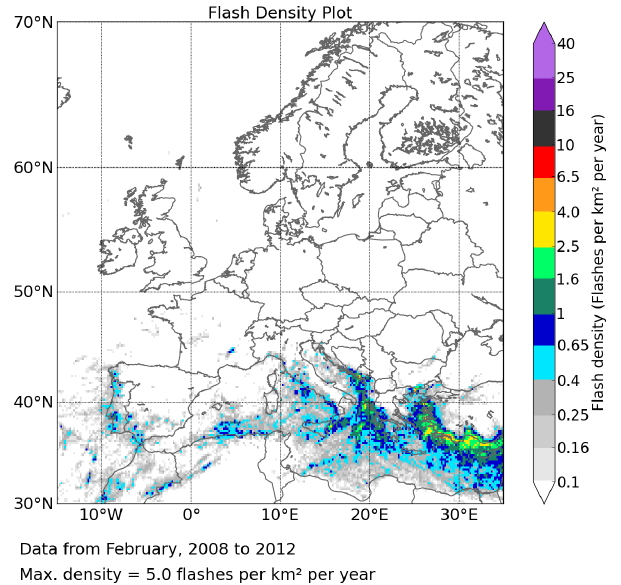
Fig. 6. Detected lightning flash density for February.